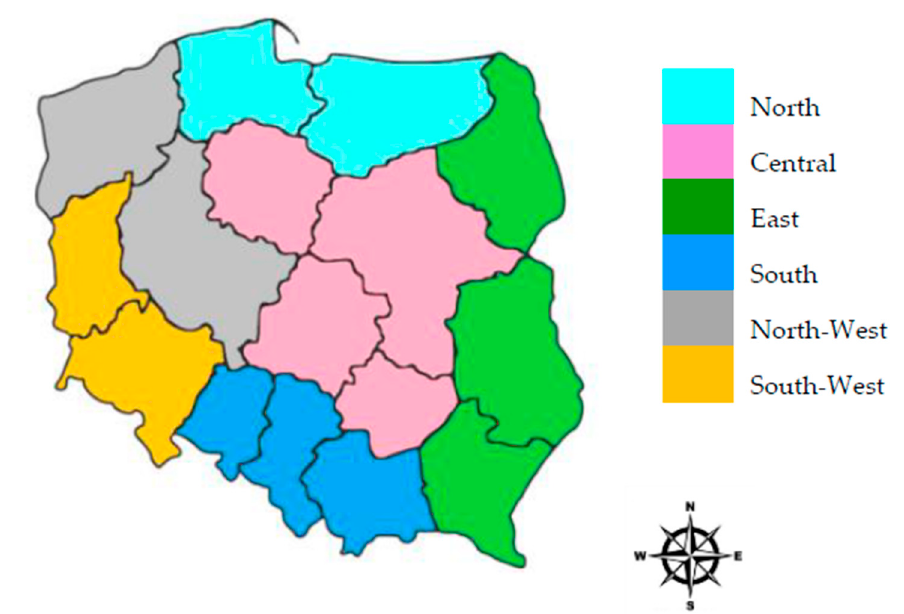
Figure 2. Division of Poland into regions. Source: Author’s own project. Table 1. Demographic description of the sample ( n = 1067).